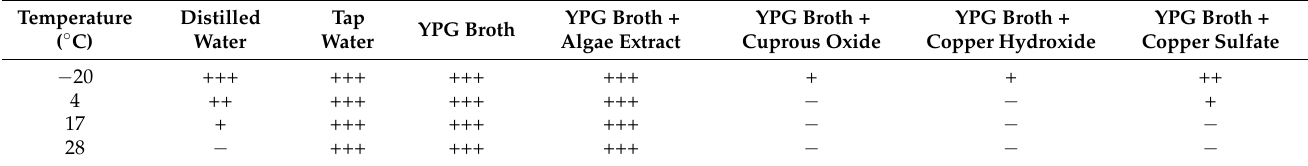
Table 2. Titer stability of phages under different liquid suspensions and temperatures 28 days post- incubation. This table gathers the results obtained from the three bacteriophages evaluated inde- pendently.